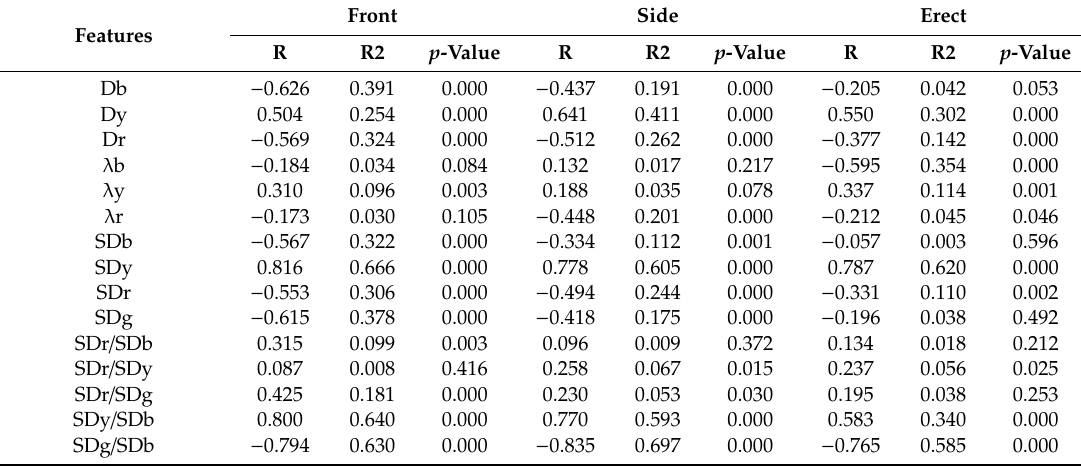
Table 5. Correlation between derivative features and disease severity.